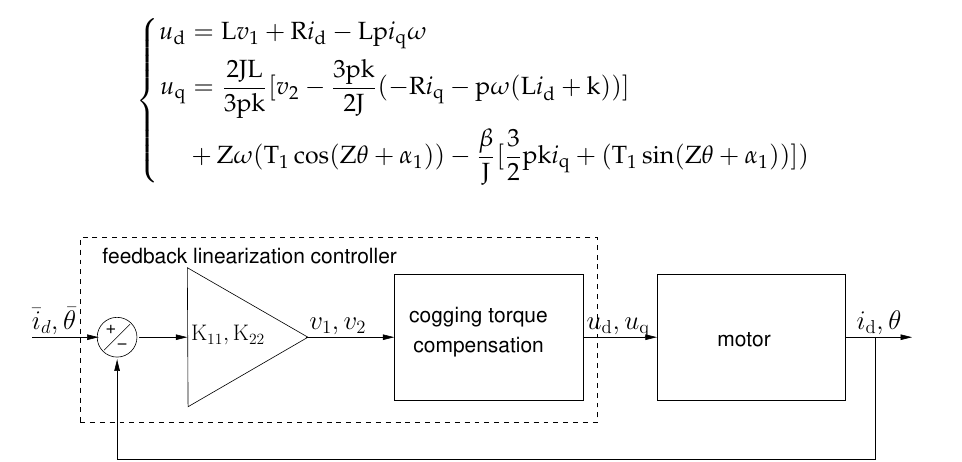
Figure 4. Schematic representation of the control loop.